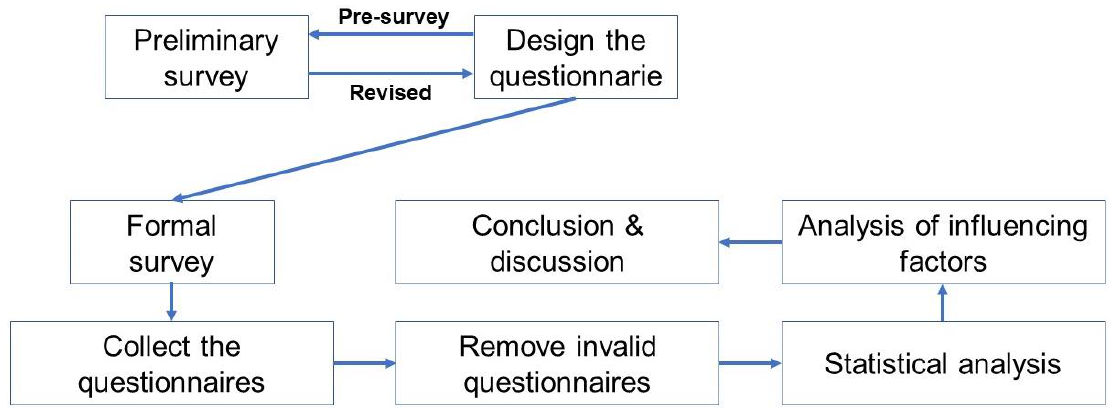
Figure 2. Steps of